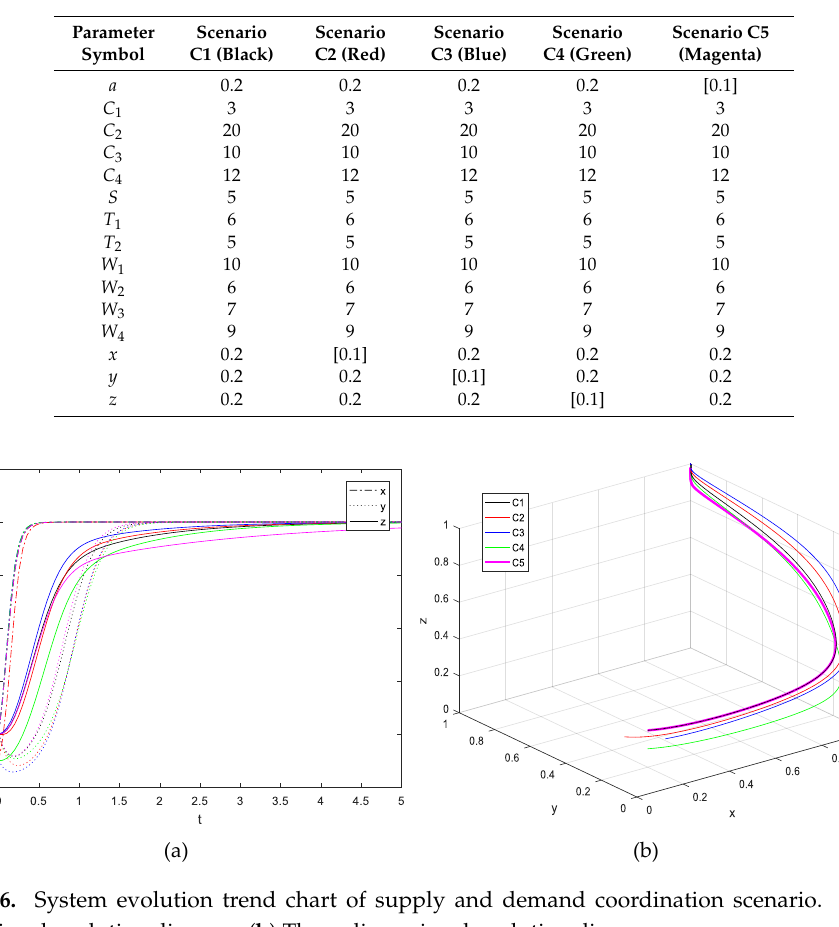
Table 6. Value of supply and demand coordination scenario.